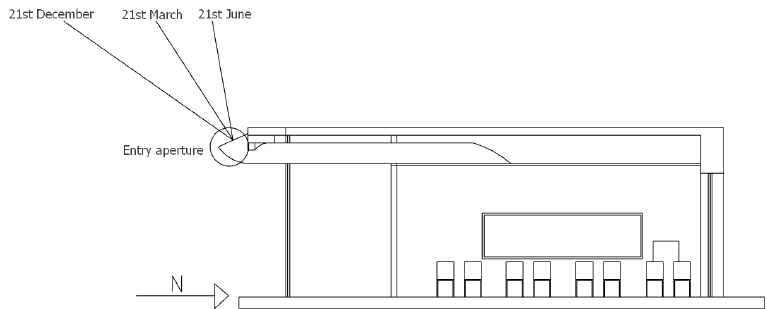
Figure 25. Solar altitudes of 21 st of March, June, and December in relation to the entry aperture of the southern anidolic ducts.